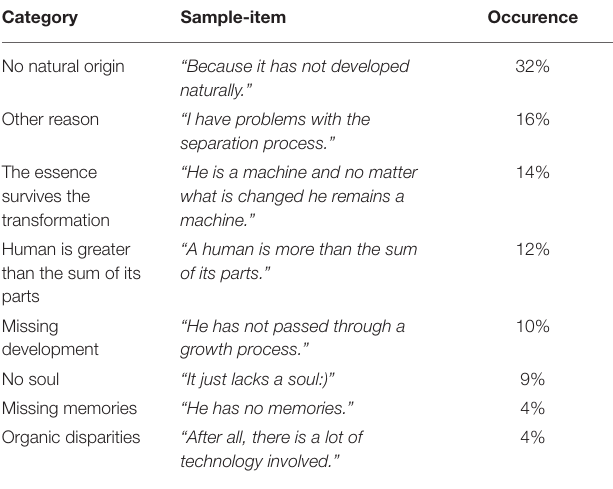
TABLE 2 | The participants’ reasons why the transformation process does not lead to a completely human-like entity in the robot-to-human condition. Question: If you think the robot is still—after replacing all parts—not completely humanlike, why is